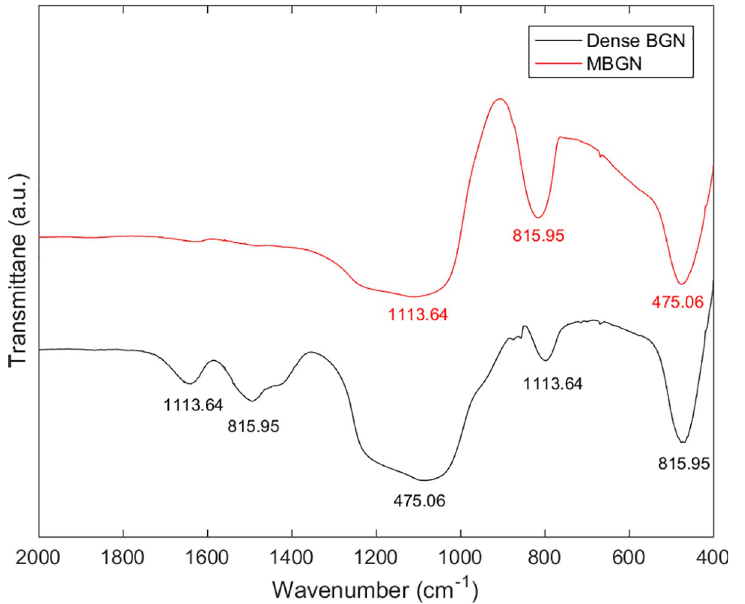
Fig 4. FT-IR pattern of MBGN and Dense BGN.